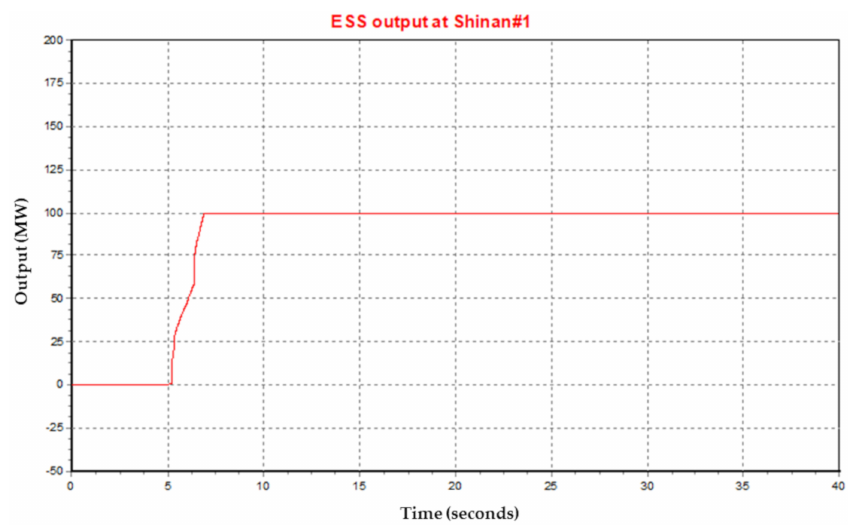
Figure 12. ESS output at Shinan